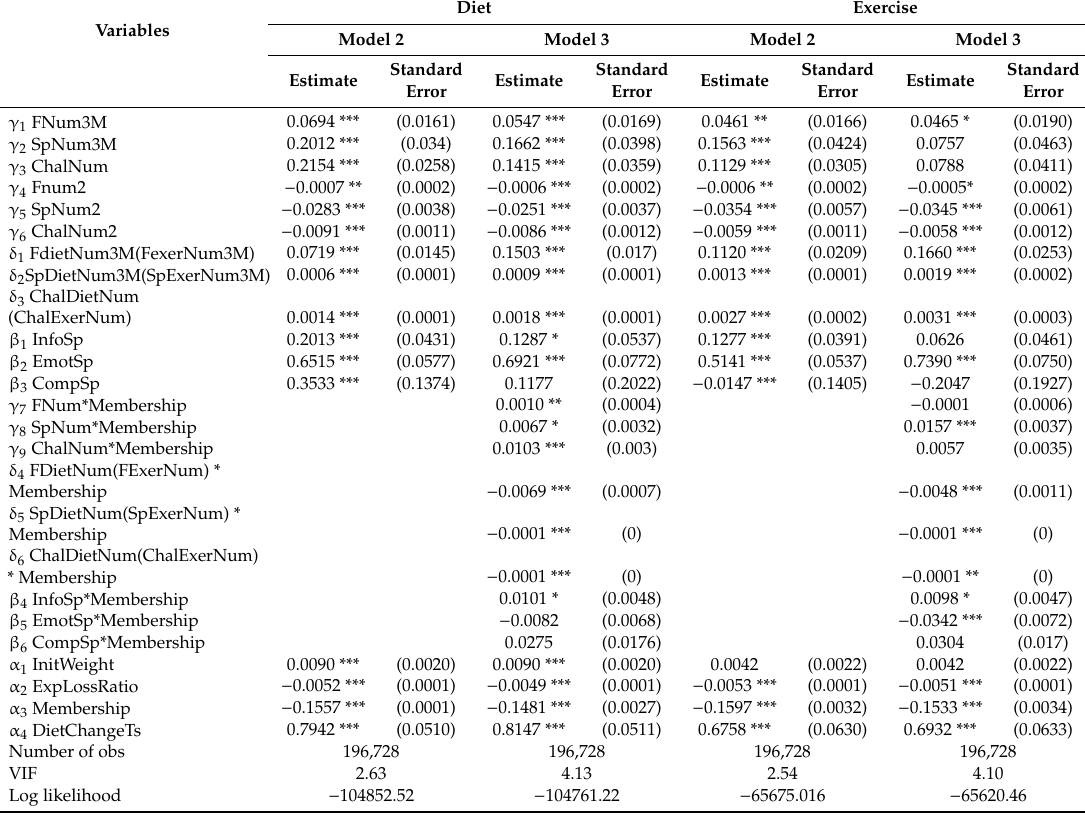
Table 4. Estimated results with time e ff